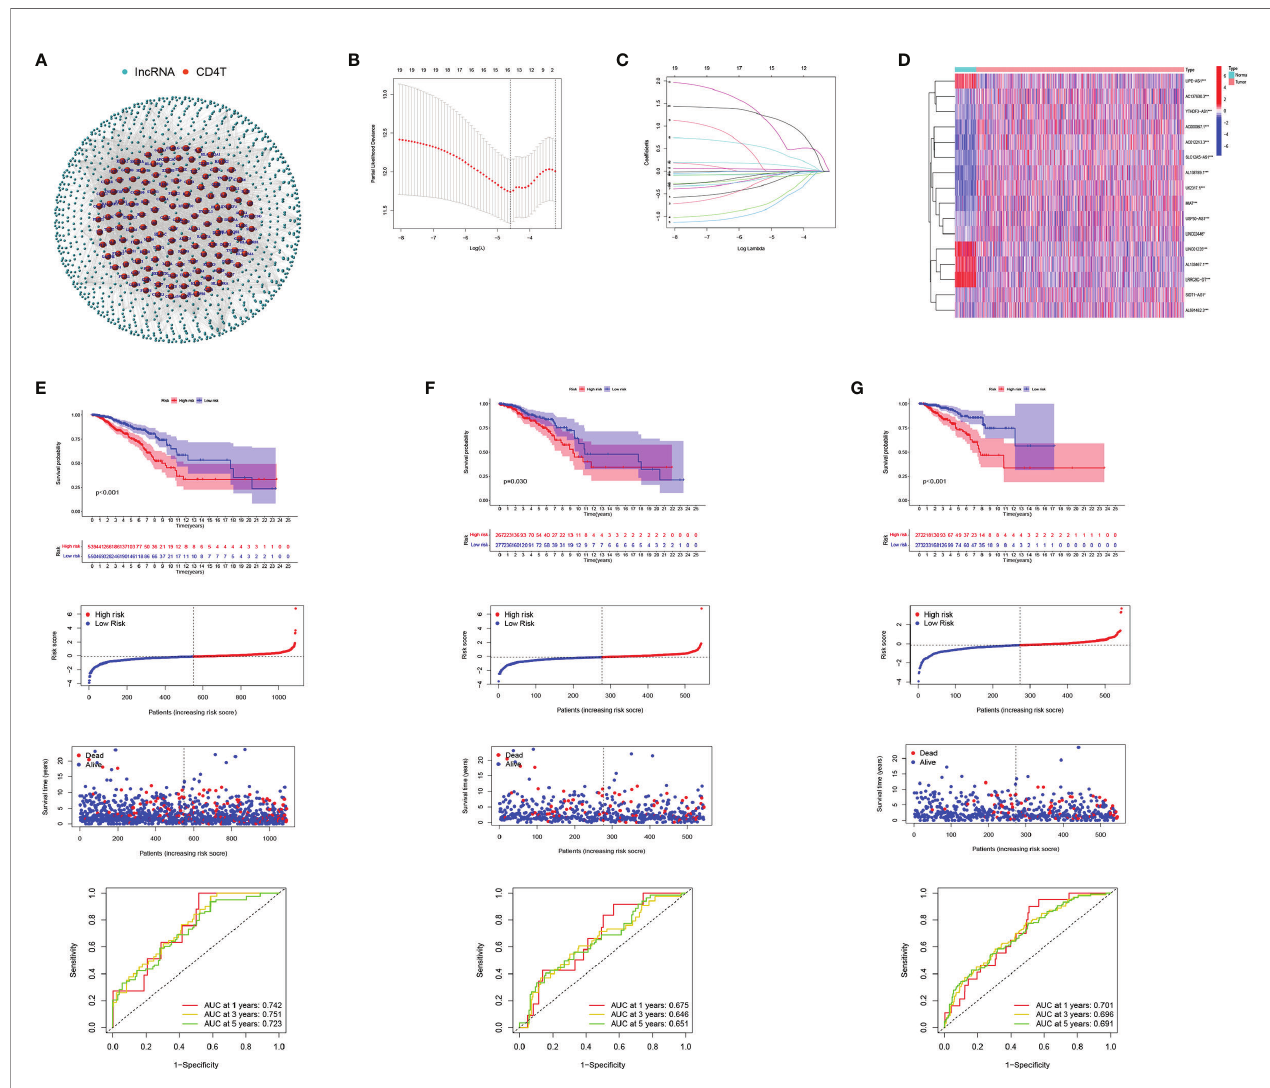
FIGURE 5 | Development and validation of CD4TLAs-Related Risk Signature. (A) Co-expression network of lncRNAs and CD4 + Tconv-related genes. (B) Cross ‐ validation for tuning parameter selection in the lasso regression. (C) Validation was performed for tuning parameter selection through the least absolute shrinkage and selection operator (LASSO) regression model for overall survival (OS). (D) The heatmap shows the expression distribution of A. (E) CD4TLAs-related prognostic model constructed in total BC patients. (F) Validation cohort 1. (G) Validation cohort 2. From top to bottom: Kaplan-Meier survival analysis of high- and low-RS subgroups; risk score between high- and low-risk groups; patient survival time; plots of the AUC for time-dependent ROC